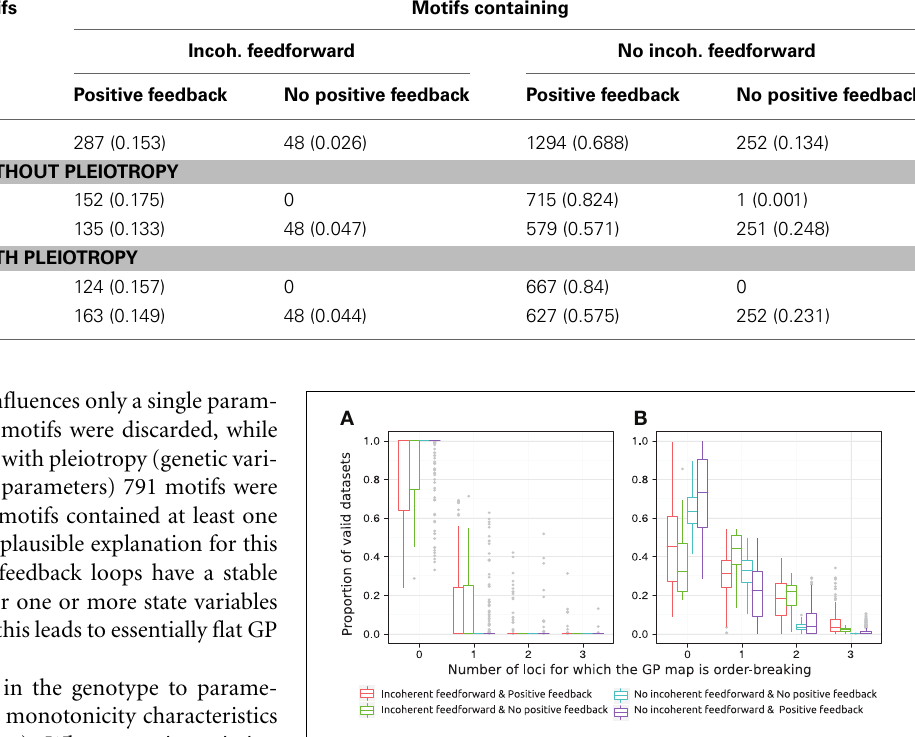
FIGURE 5 | Order-breaking in motifs containing a single feedforward loop. Summary of order-breaking for all motifs for which at least 100 (out of 1000) Monte Carlo simulations lead to GP maps with non-negligible variation (see Models and Methods section “Gene regulatory network simulations,” for detailed criteria). Results are shown for 1013 motifs with a genotype-to-parameter map without pleiotropy (A) and 1090 motifs with a genotype-to-parameter map with pleiotropy (B) . Colors indicate classes of motifs based on the presence/absence of incoherent feedforward and positive feedback loops, see Table 1 for the number of motifs in each class. A single boxplot summarizes, for all motifs in the given class, the proportion of the GP maps (y-axis) that are order-breaking with respect to a given number of loci (x-axis). For example, consider the red box at x = 0 in panel (A) . This boxplot contains results for motifs with both incoherent feedforward and positive feedback and from Table 1 we find that the red boxplot summarizes results for 135 motifs. From the y-axis we find that at least half (box median at y = 1) of these 135 motifs result in only monotone GP maps, while for the most extreme (end of whisker) of the 135 motifs only 25% of the GP maps are monotone. Similarly, the cyan box is compressed into a line at x = 0, y = 1 indicating that all 251 motifs that lack both incoherent feedforward and positive feedback result in only monotone GP